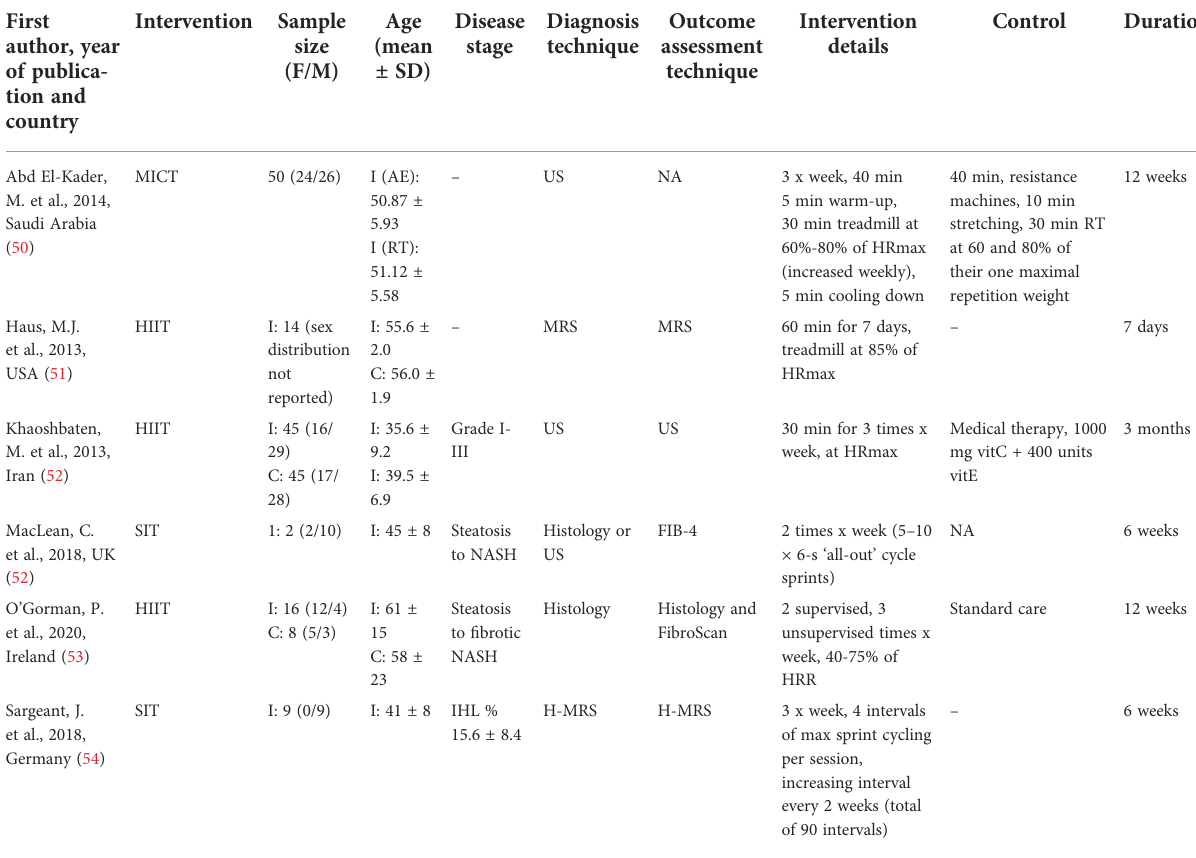
TABLE 2 The characteristics of the included non-randomized controlled trials